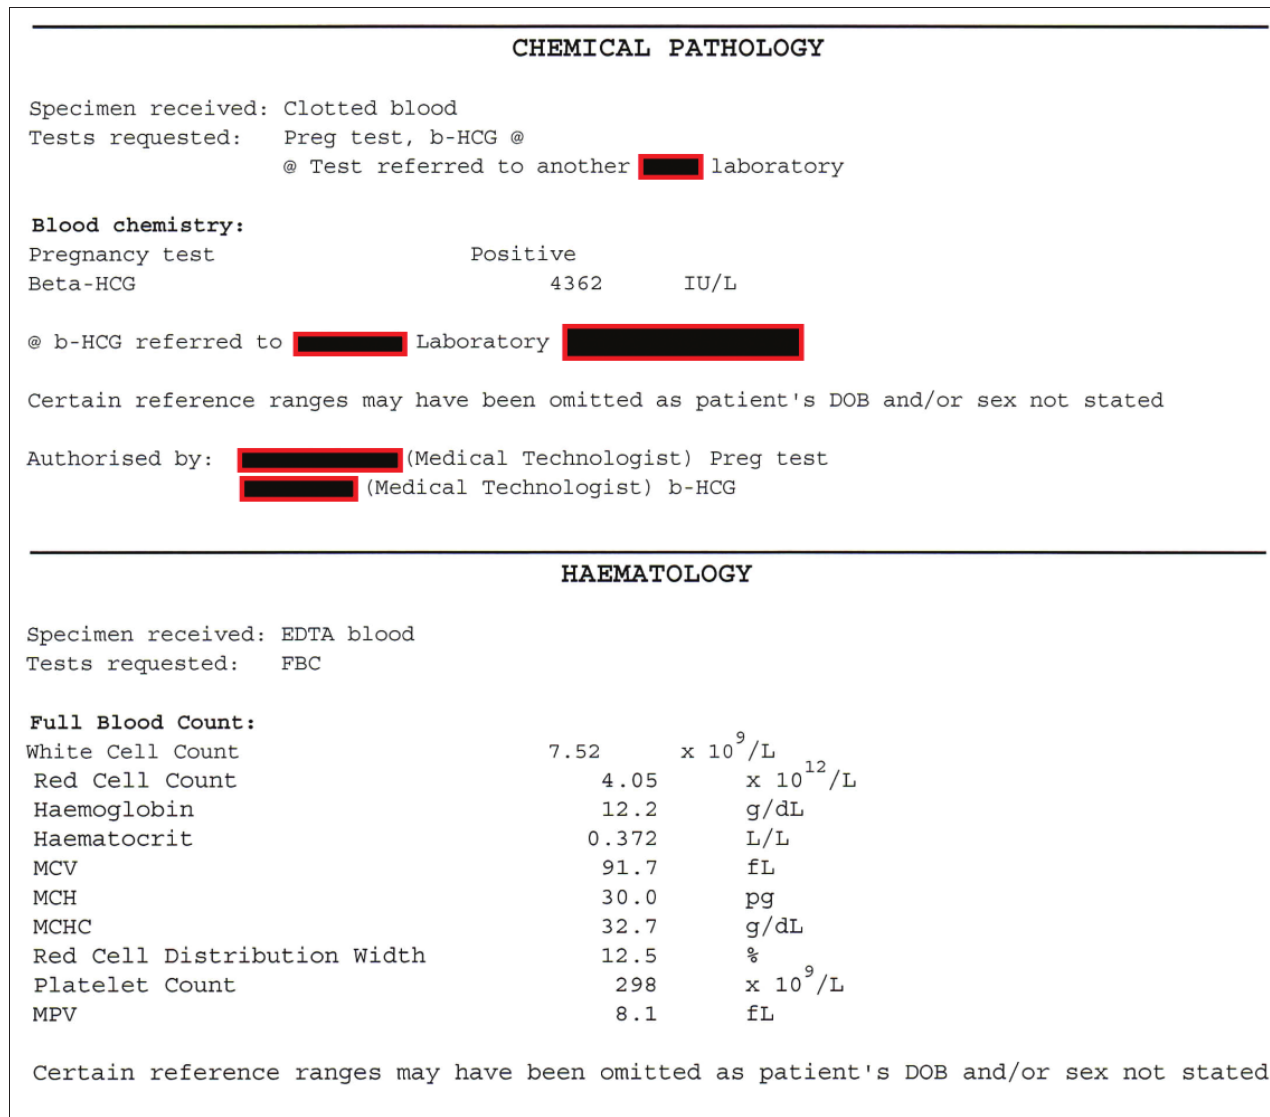
FIGURE 2: Laboratory report.